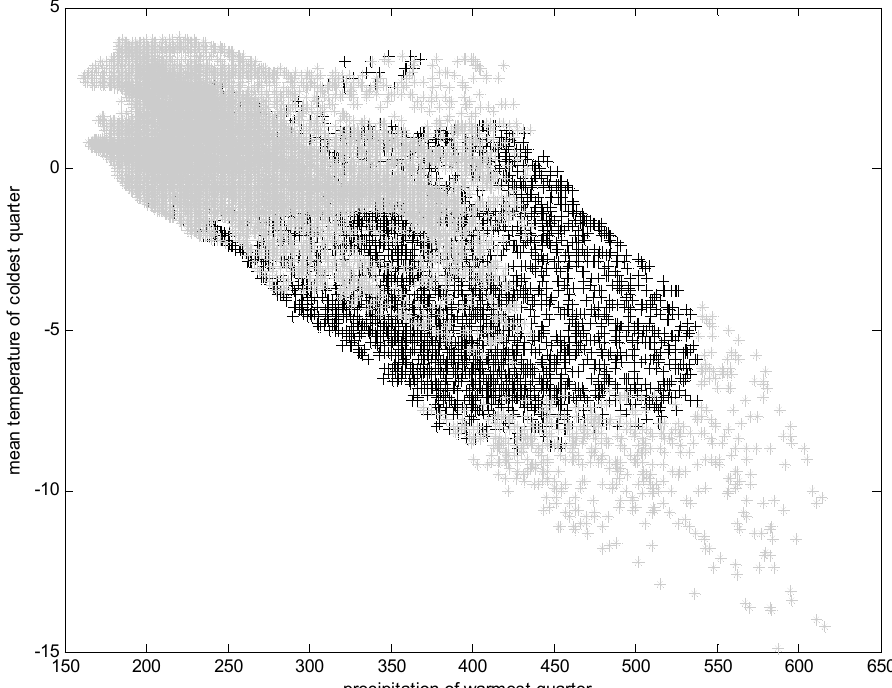
Figure 2. Modelled result of the ecological niche of the bank voles according to the precipitation of the warmest quarter (mm) and mean temperature of the coldest quarter (°C). The black crosses represent the suitable ecological niche of the bank voles.